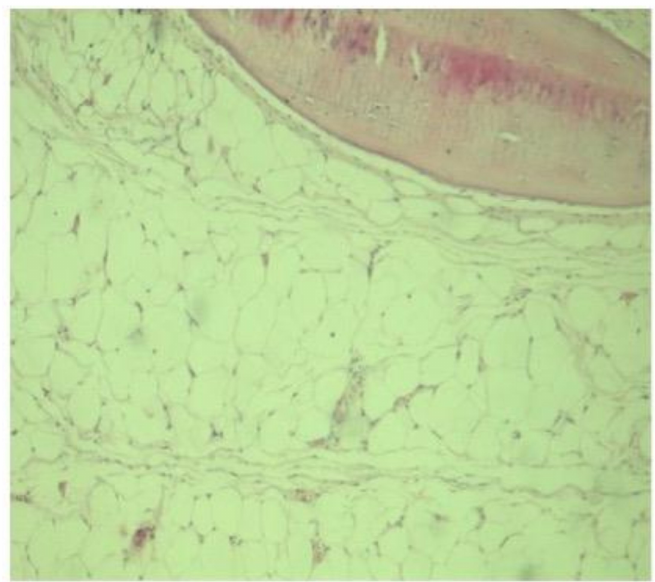
Figure 4. Histological specimen showing adipose tissue (lobulated with areas of mature lipocytes) in apposition with small areas of medullary trabecular bone (upper right corner).